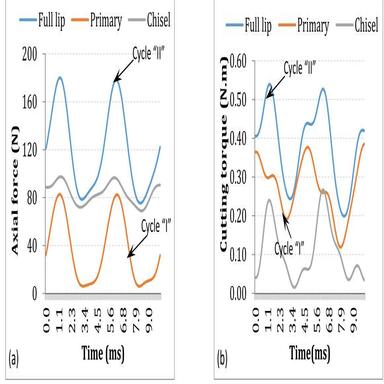
Separated behavior of the (a) axial force and (b) cutting torque of the full cutting lip, the primary cutting edges and the chisel edge during the defined cycles of tool rotation at (n = 6000 rev/min, and fr =0.15 mm/rev).